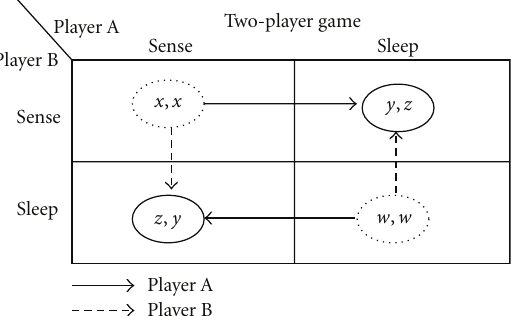
Figure 6: Payo ff matrix for 2-player game. network utility or payo ff involving populations following di ff erent strategies is defined as